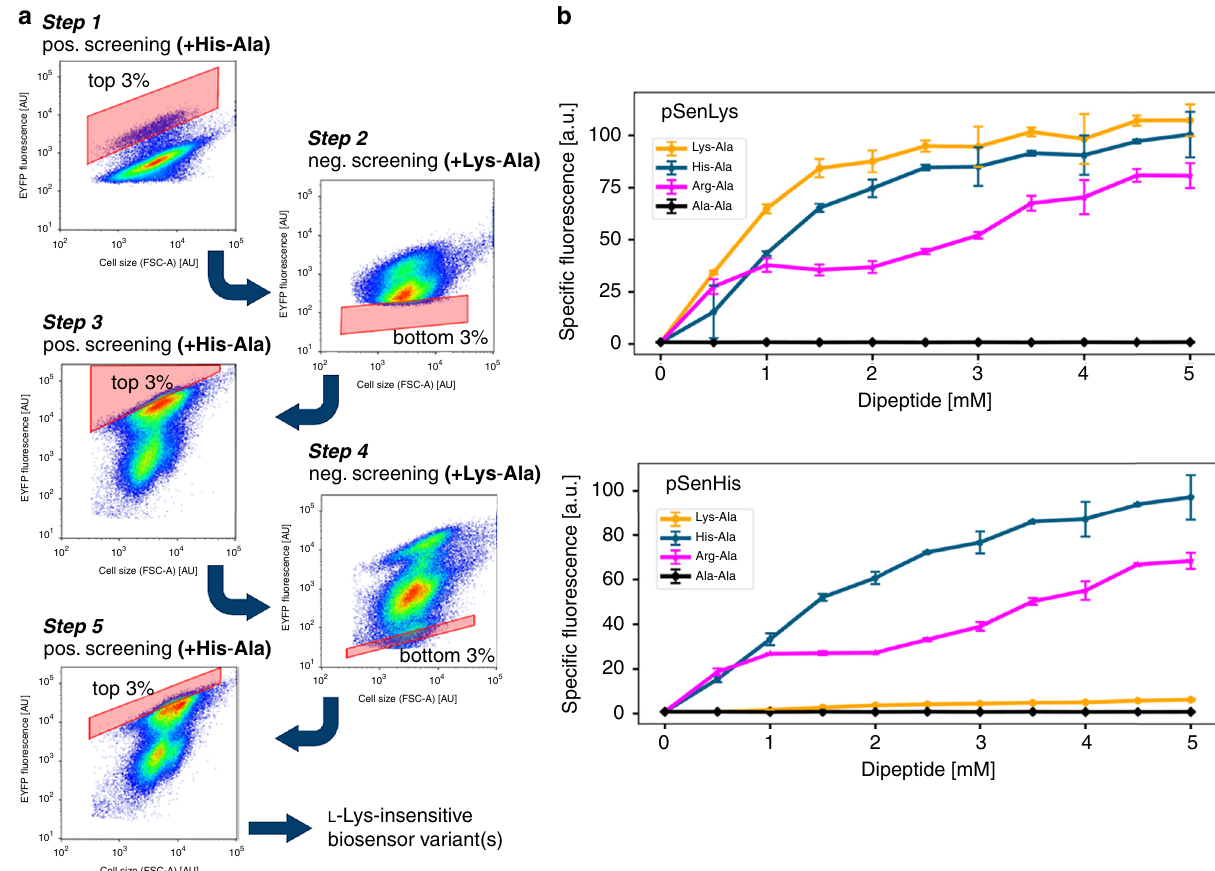
Fig. 2 FACS-based positive/negative screening to identify an L -lysine-insensitive biosensor. a FACS plots obtained during the fi ve-step screening/ counterscreening campaign for identifying L -lysine-insensitive L -histidine biosensor variants. During this procedure, fl uorescent cells responding to L -His- L - Ala dipeptides were collected during positive screening, alternating with a collection of non fl uorescent cells during negative screening in the presence of L - Lys- L -Ala dipeptides. During the last positive screening, 96 individual clones were sorted for further characterization. b Initial characterization of the identi fi ed L -lysine-insensitive biosensor variant. Fluorescence response of the biosensors pSenLys (top) and pSenHis (bottom) to the presence of various dipeptides at different concentrations during microtiter plate cultivations. In each case, the speci fi c fl uorescence as ratio of the fl uorescence determined after 22 h over the culture backscatter (as measure for cell density) is shown. All data represent mean values from three biological replicates including standard